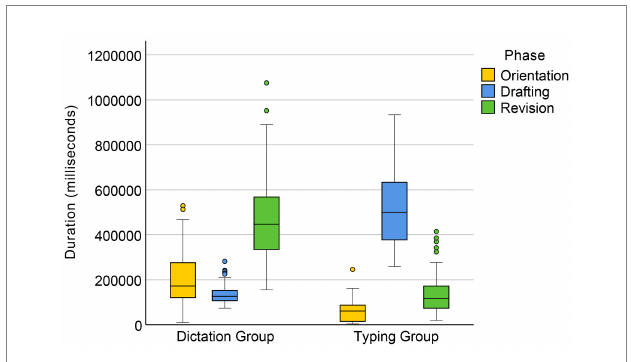
FIGURE 1 Time allocation in dictation and typing